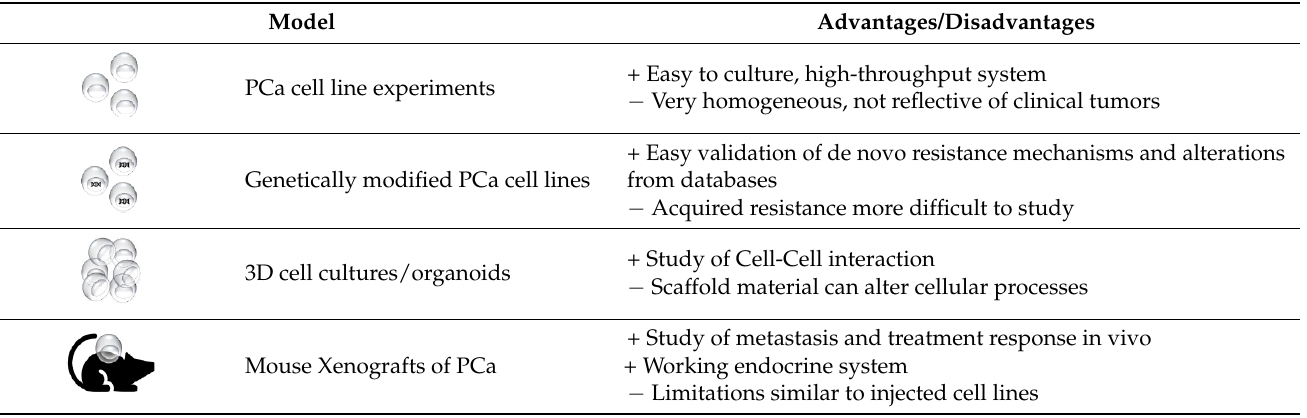
Table 3. Overview of the advantages and disadvantages of different preclinical models. General PCa-derived and patient- derived models (indicated in color) are discussed. Prostate cancer,